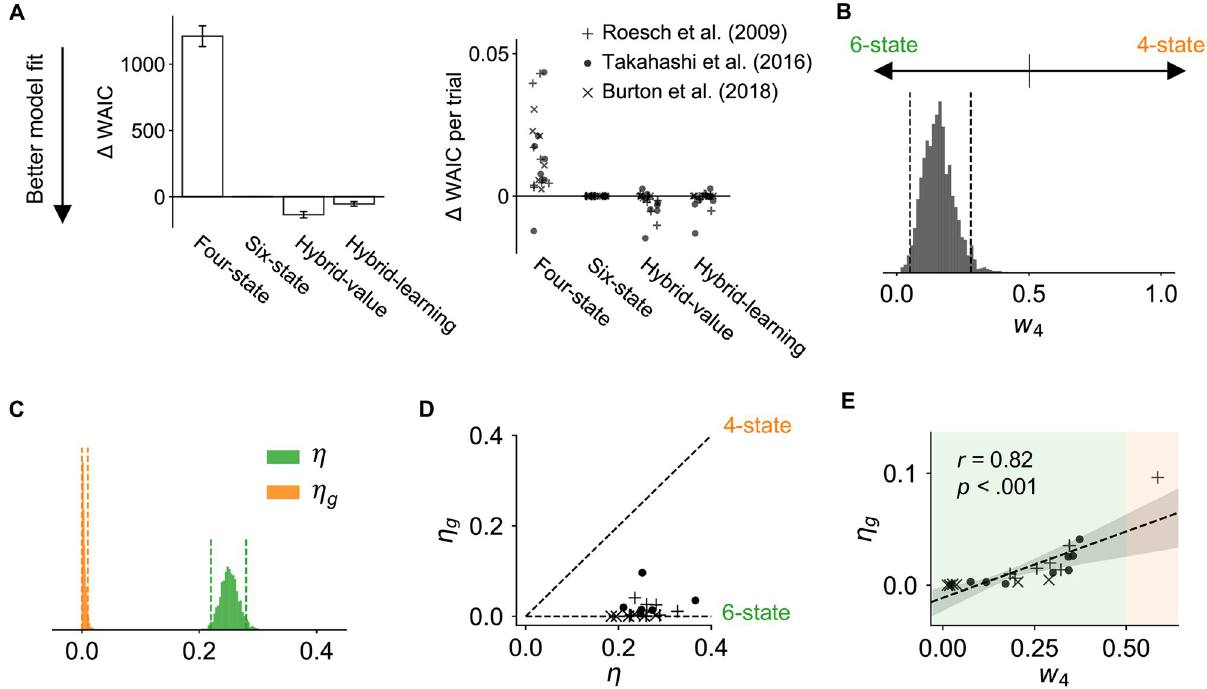
Fig 3. The six-state representation explains animals’ choices better than the four-state alternative. (A) Model comparison results. Left: WAIC difference between all four models and the six-state model for the entire dataset (summed across all trials from all animals). Lower values indicate better model fits. Error bars represent standard errors across samples [16]. Right: individual differences in average WAIC per trial between all models and the six-state model. Each marker corresponds to an individual animal, with different markers representing different datasets (same in D and E). (B) Posterior distribution of the group mean of four-state weight w 4 in the hybrid-value model. Dashed lines represent 95% HDI. w 4 = 0 corresponds to the six-state model, and w 4 = 1 corresponds to the four-state model. (C) Posterior distribution of the group mean of learning rate η (in green) and (in orange) in the hybrid-learning model. Dashed lines represent 95% highest density interval (HDI). Generalization is almost generalization rate η g negligible due to the low values of η g . (D) Posterior mean of η and η g for each animal. The horizontal dashed line corresponds to the six-state model; the diagonal dashed line corresponds to the four-state model. (E) The correlation between w 4 in the hybrid-value model and η model at the individual level.